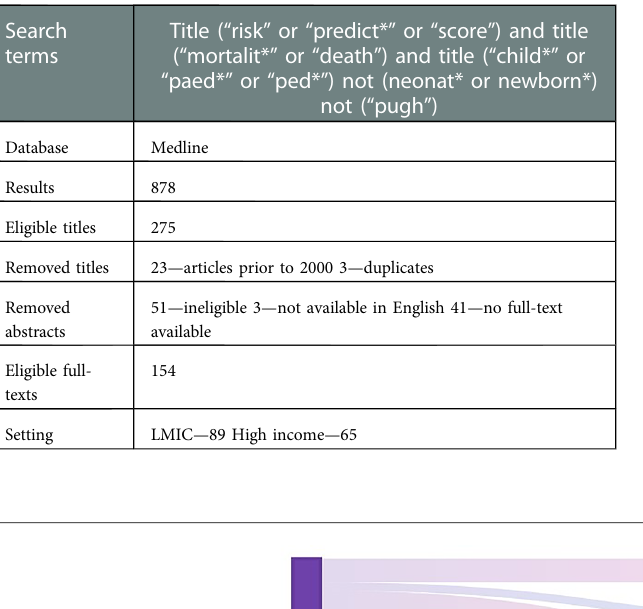
TABLE 1 Literature search